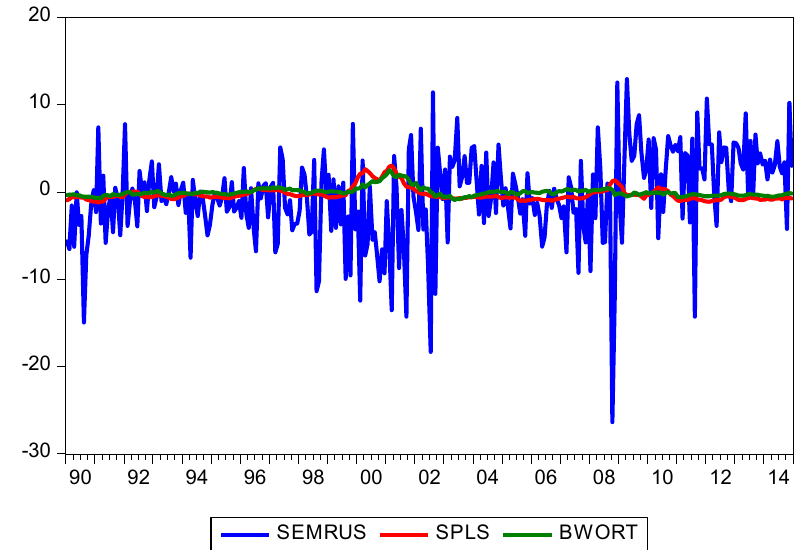
Figure 2. Plot of the sentiment indices, SPLS and BWORT, and the stock market returns, SEMRUS, for the entire range of 1990–2014.